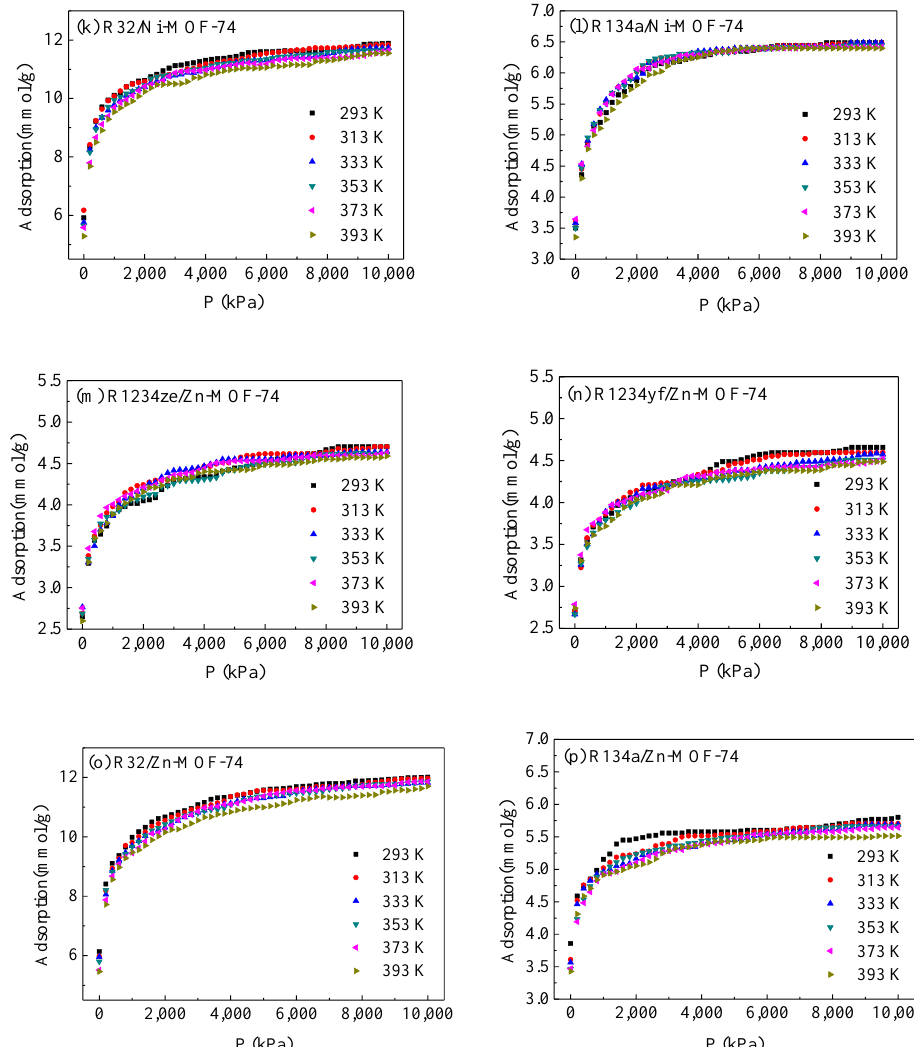
Figure 5. Adsorption isotherms of refrigerants in M-MOF-74 at different temperatures. ( a ) R1234ze/Co-MOF-74; ( b ) R1234yf/Co-MOF-74; ( c ) R32/Co-MOF-74; ( d ) R134a/Co-MOF-74; ( e ) R1234ze/Mg-MOF-74; ( f ) R1234yf/Mg-MOF-74; ( g ) R32/Mg-MOF-74; ( h ) R134a/Mg-MOF-74; ( i ) R1234ze/Ni-MOF-74; ( j ) R1234yf/Ni-MOF-74; ( k ) R32/Ni-MOF-74; ( l ) R134a/Ni-MOF-74; ( m ) R1234ze/Zn-MOF-74; ( n ) R1234yf/Zn-MOF-74; ( o ) R32/Zn-MOF-74; ( p ) R134a/Zn-MOF-74.